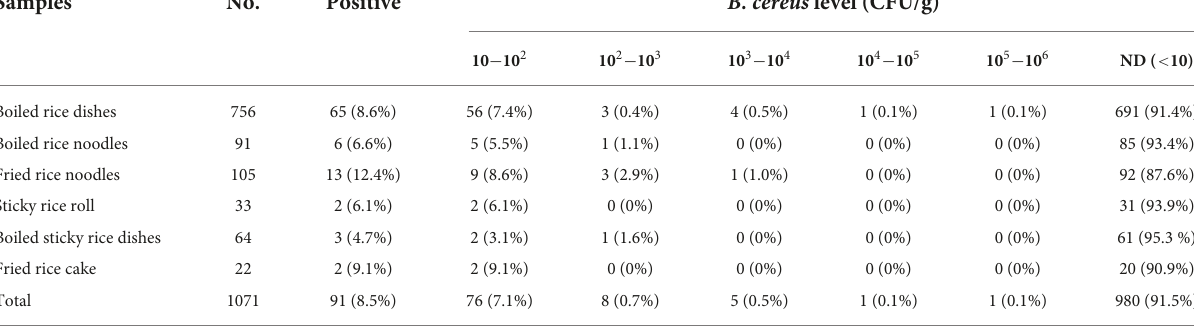
TABLE 1 Quantitative prevalence of Bacillus cereus in ready-to-eat rice product.